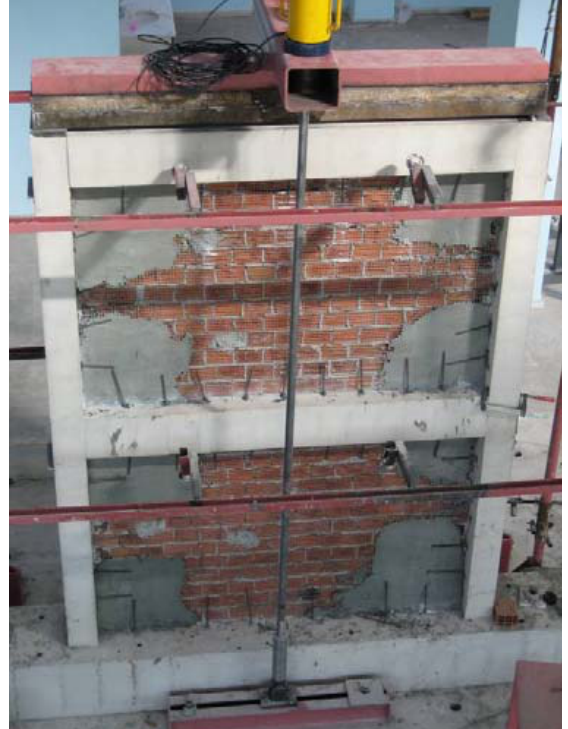
Figure 10 Failure mode of specimen SPS1